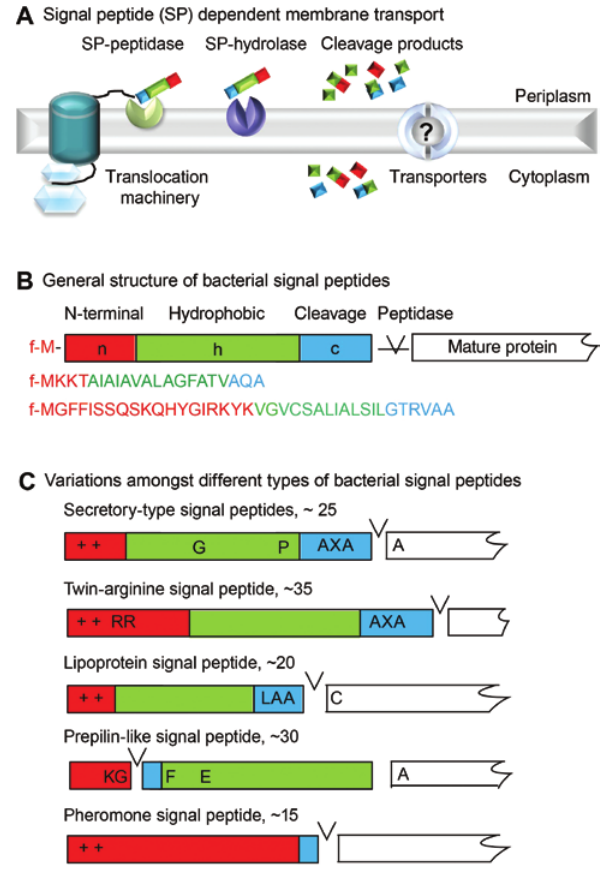
Figure 1: Metabolic pathway and structure of bacterial signal